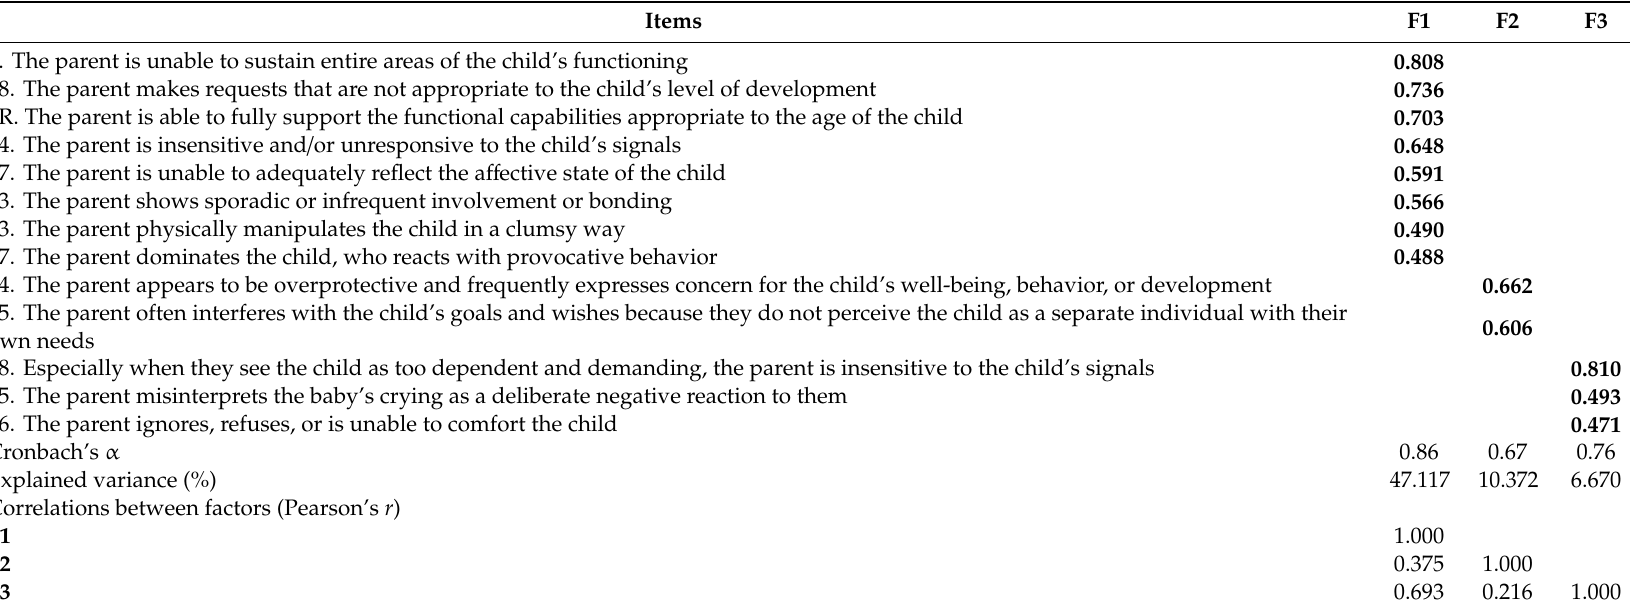
Table 2. “Parent” Area Exploratory Factor Analysis and Correlation Matrix between